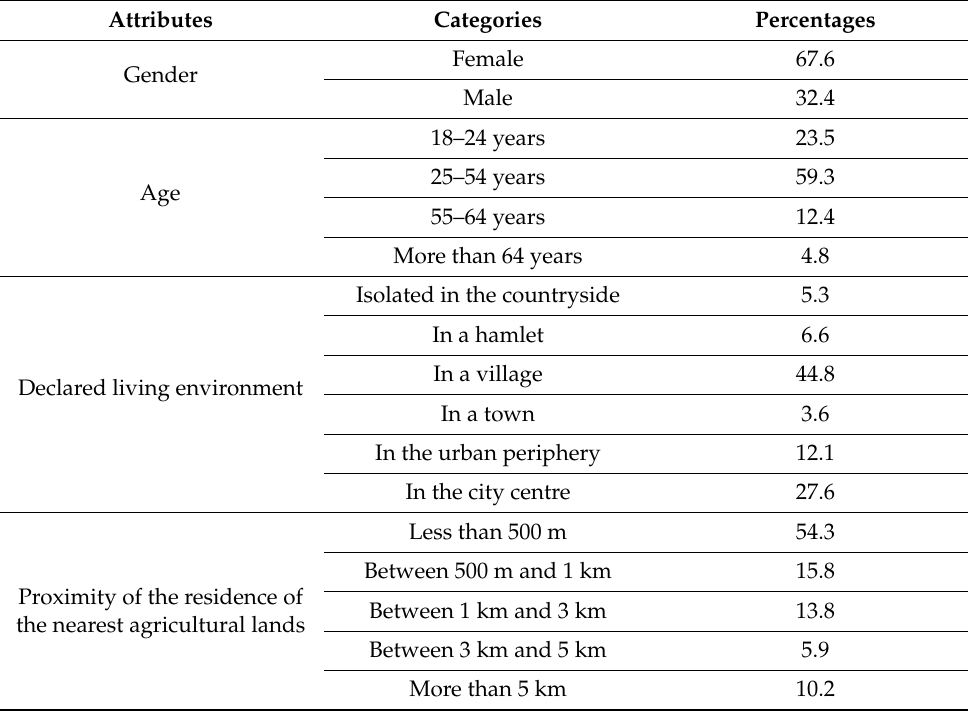
Table 1. Profile sample ( n =